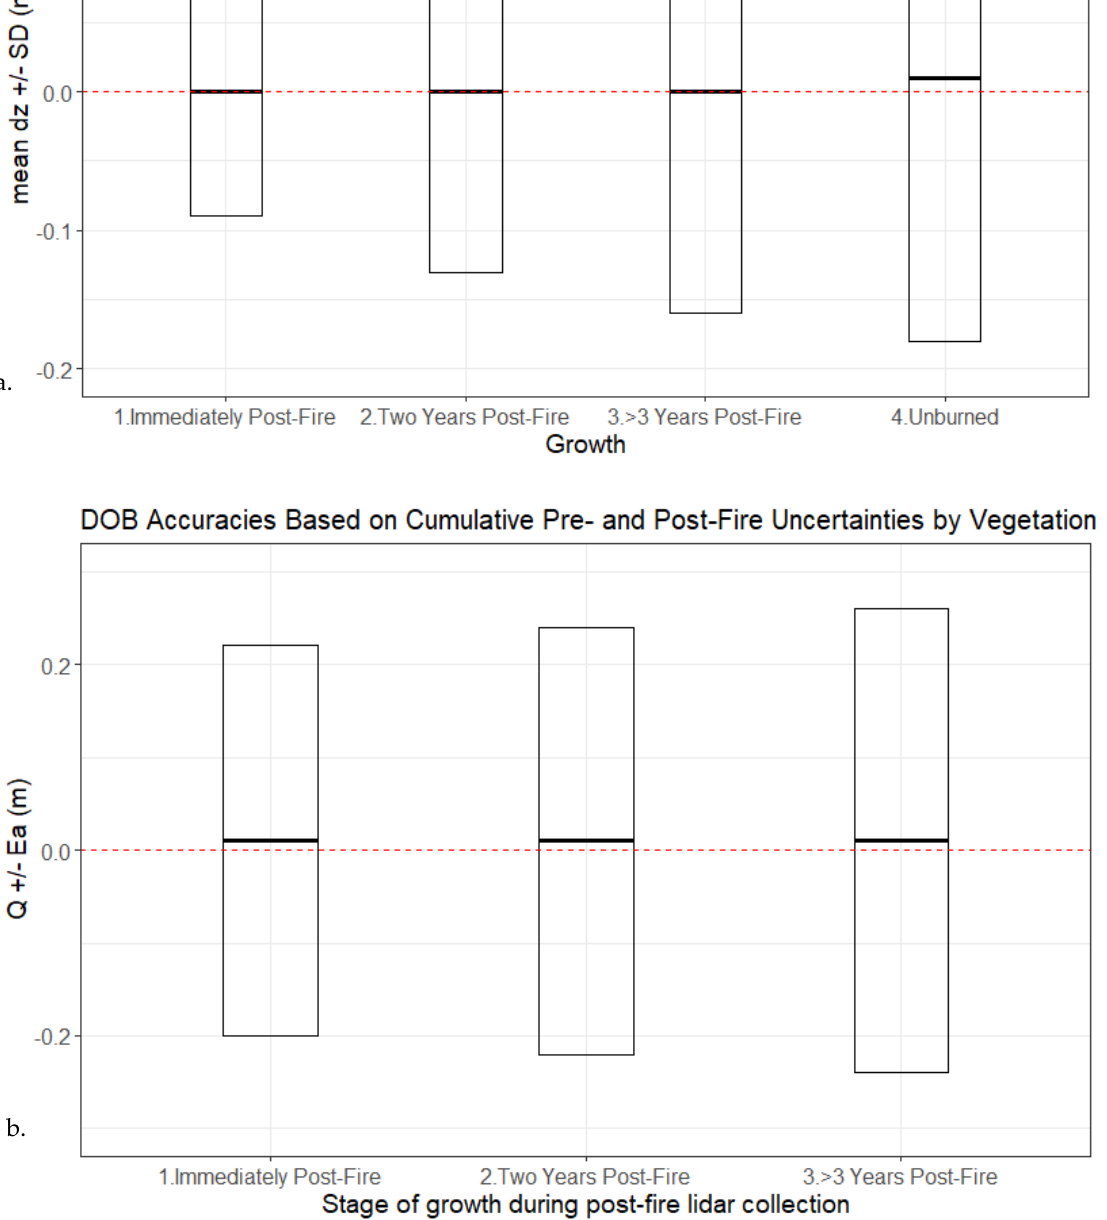
Figure 14. ( a ) Expected ground elevation accuracies of lidar data in the years following wildland fire in boreal peatlands; ( b ) Expected depth of burn (DOB) accuracies of lidar data in the years following wildland fire in boreal peatlands, assuming pre-fire lidar data were collected in “unburned conditions”, where Q = average over- or under-estimation of surface elevation change, and Ea is cumulative error (SD). Note: for all measurements used, SD was equal to RMSE.